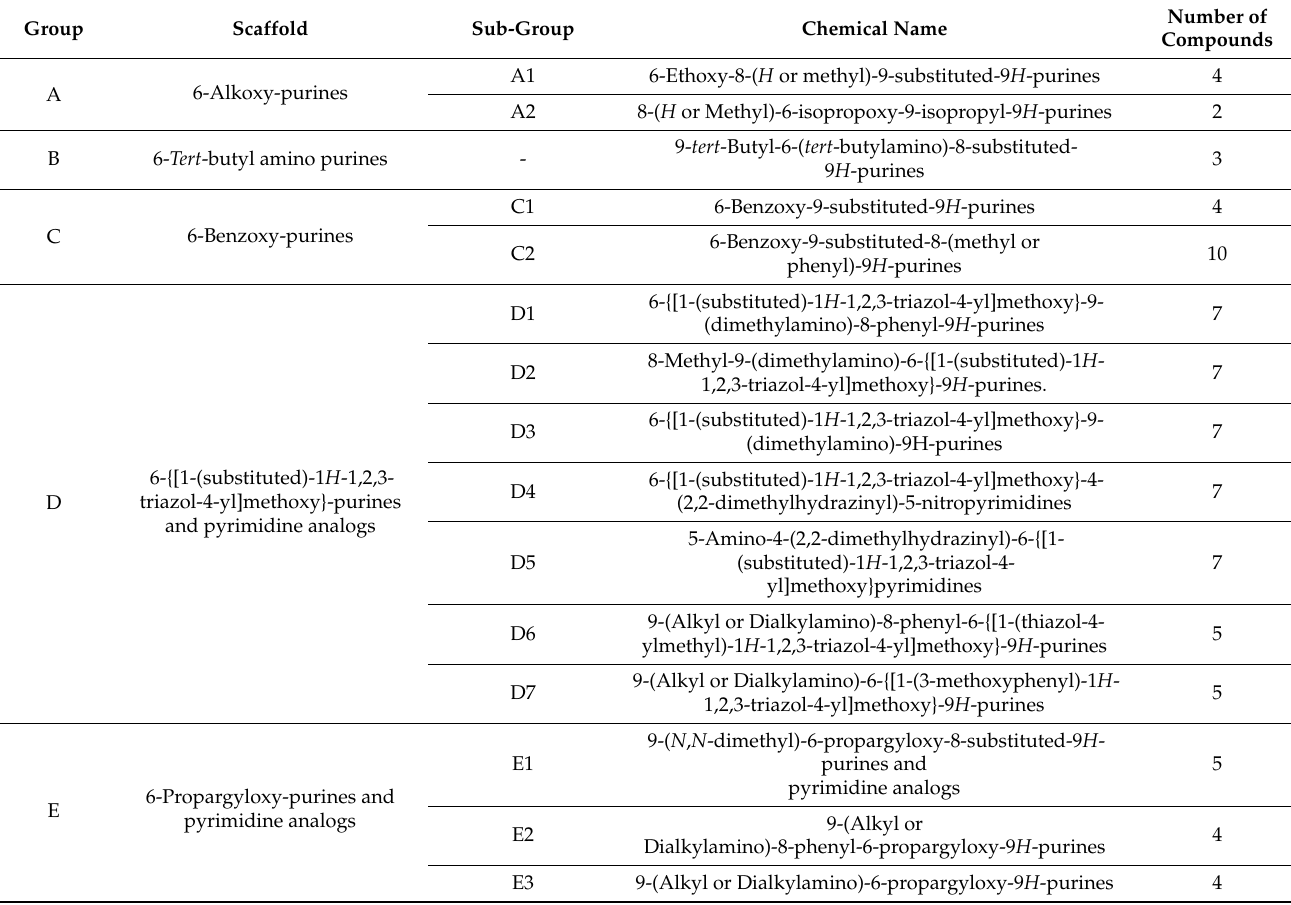
Table 5. Classification of the compounds within the chemical collection evaluated in this study. Group